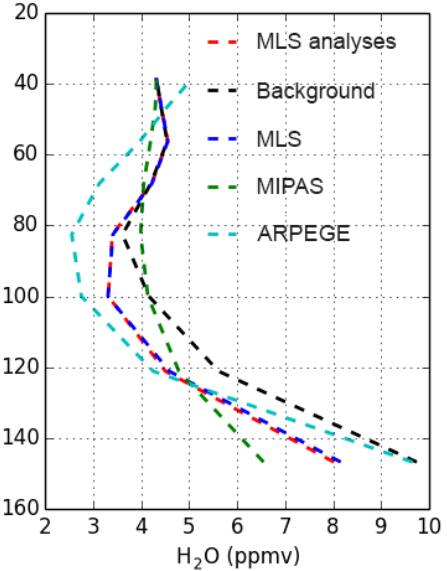
ical UTLS (30 ◦ S–30 ◦ N) in January 2012 in the MLS observa- tion space from MLS analyses (red dashed line), background (black dashed line), MLS (blue dashed line), MIPAS (green dashed line) and ARPEGE (light blue